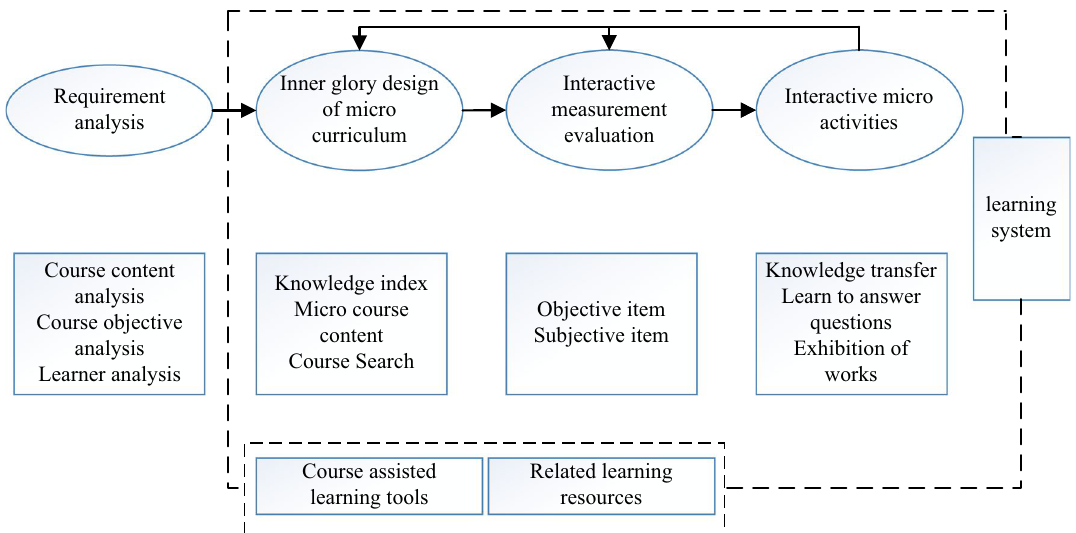
Fig. 5 Microcourse design